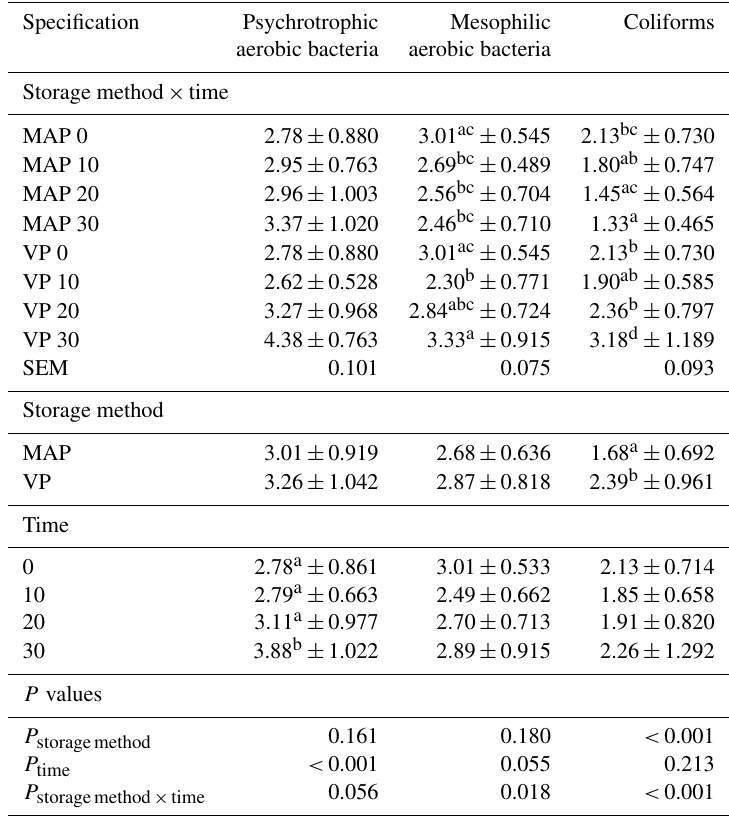
Table 2. Effect of vacuum packaging and modified atmosphere packaging on microbial counts (log 10 UFC/g) of fresh lamb meat during storage at 4 ◦